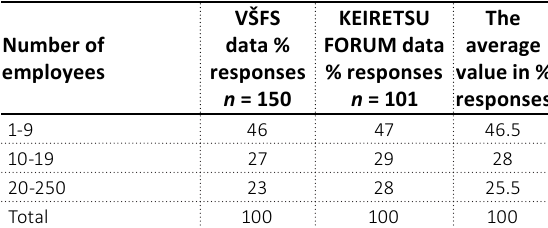
Table 4. Structure of analyzed startups